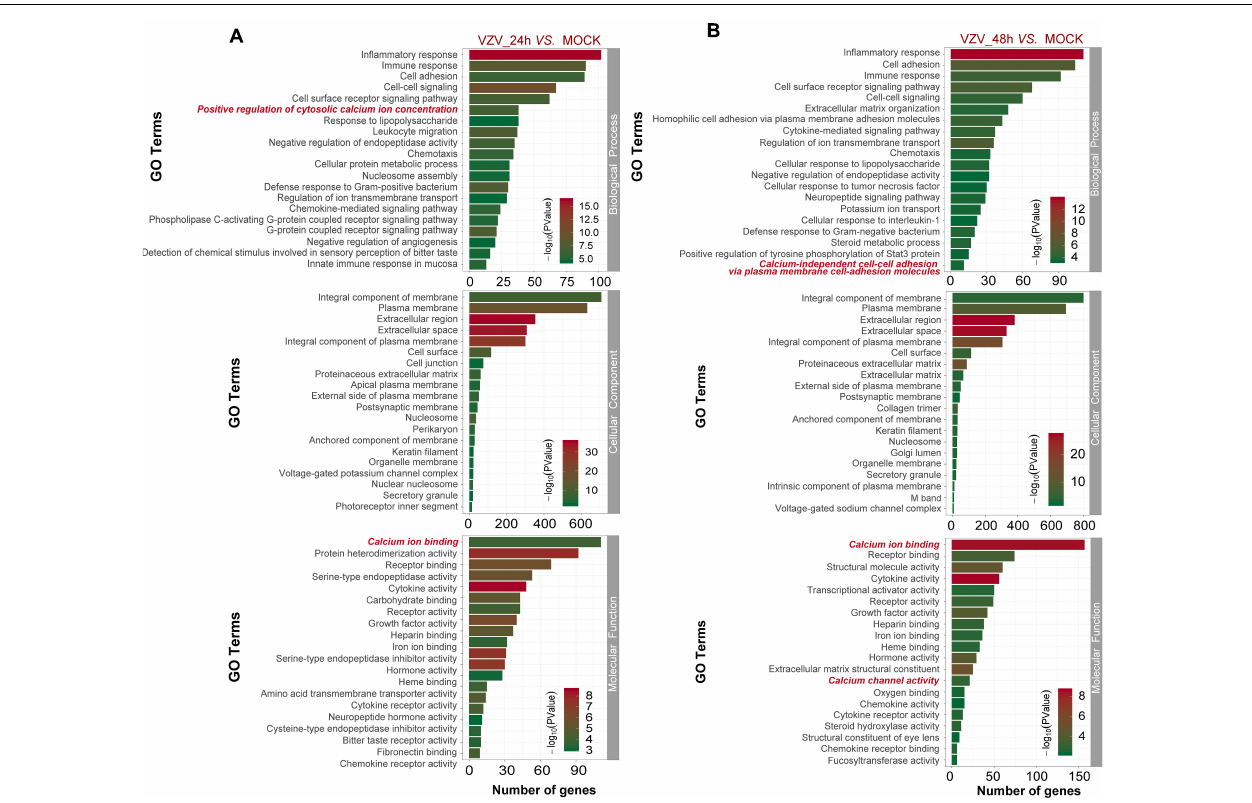
FIGURE 3 | The functional enrichment of DEGs was analyzed by gene ontology classification. (A) GO analysis of DEGs in SH-SY5Y cells 24 h after VZV infection. (B) GO analysis of DEGs in SH-SY5Y cells 48 h after VZV infection. The number of DEGs was plotted as abscissa and GO terms were plotted as ordinate. It shows the top 20 highly representative GO terms enriched in DEGs, including biological processes, cellular components, and molecular